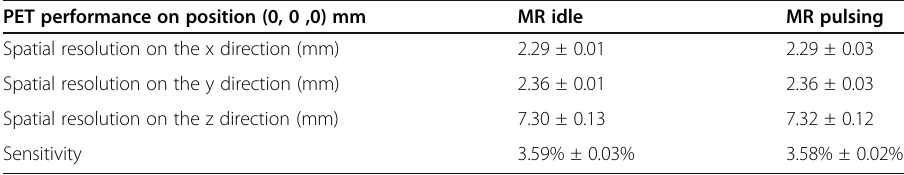
Table 5 Spatial resolution and sensitivity under different conditions PET performance on position (0, 0 ,0) mm MR idle Spatial resolution on the x direction (mm) Spatial resolution on the y direction